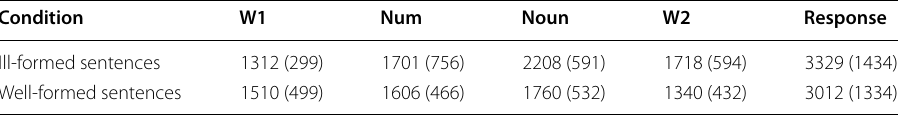
Table 7 Mean RTs for Numeral Count Noun for sentence types + Condition W1 Num Noun W2 Response Ill-formed sentences Well-formed